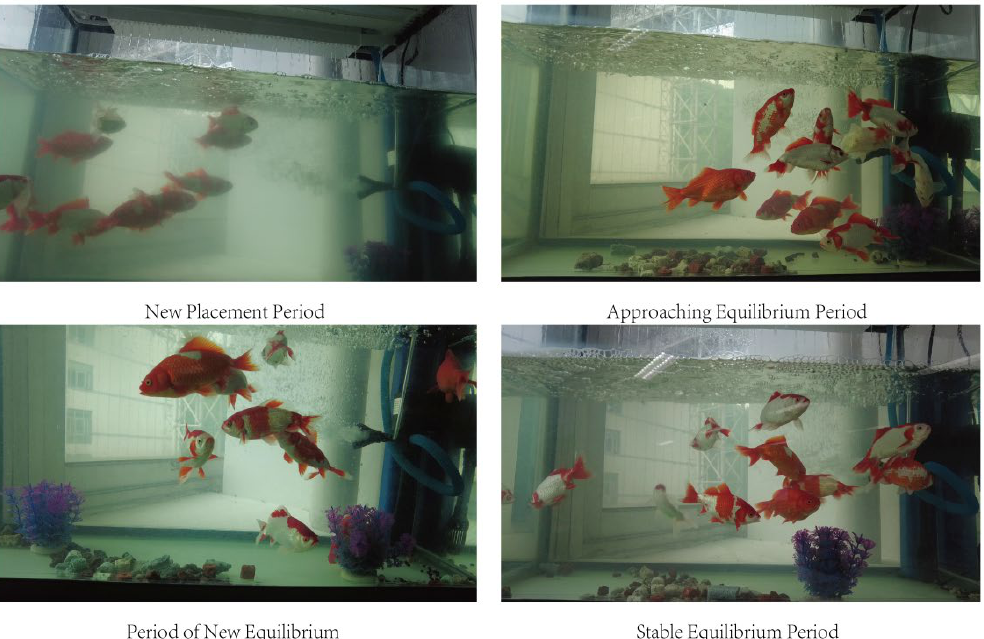
Figure 3. Four different water quality examples.